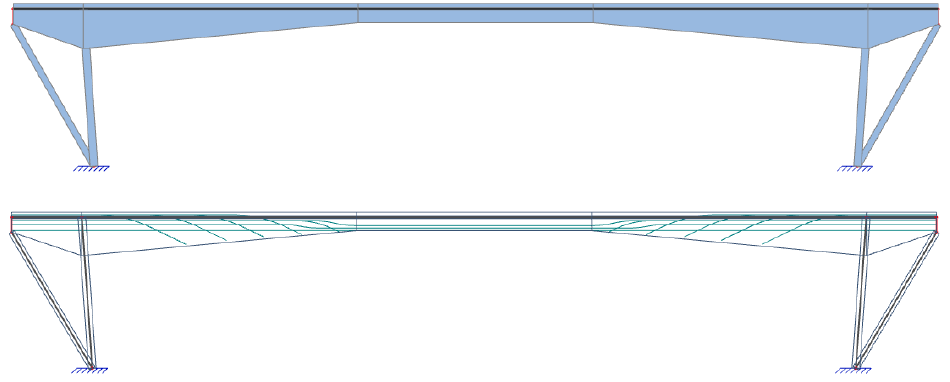
Figure 13. FE model used for TDA analysis.